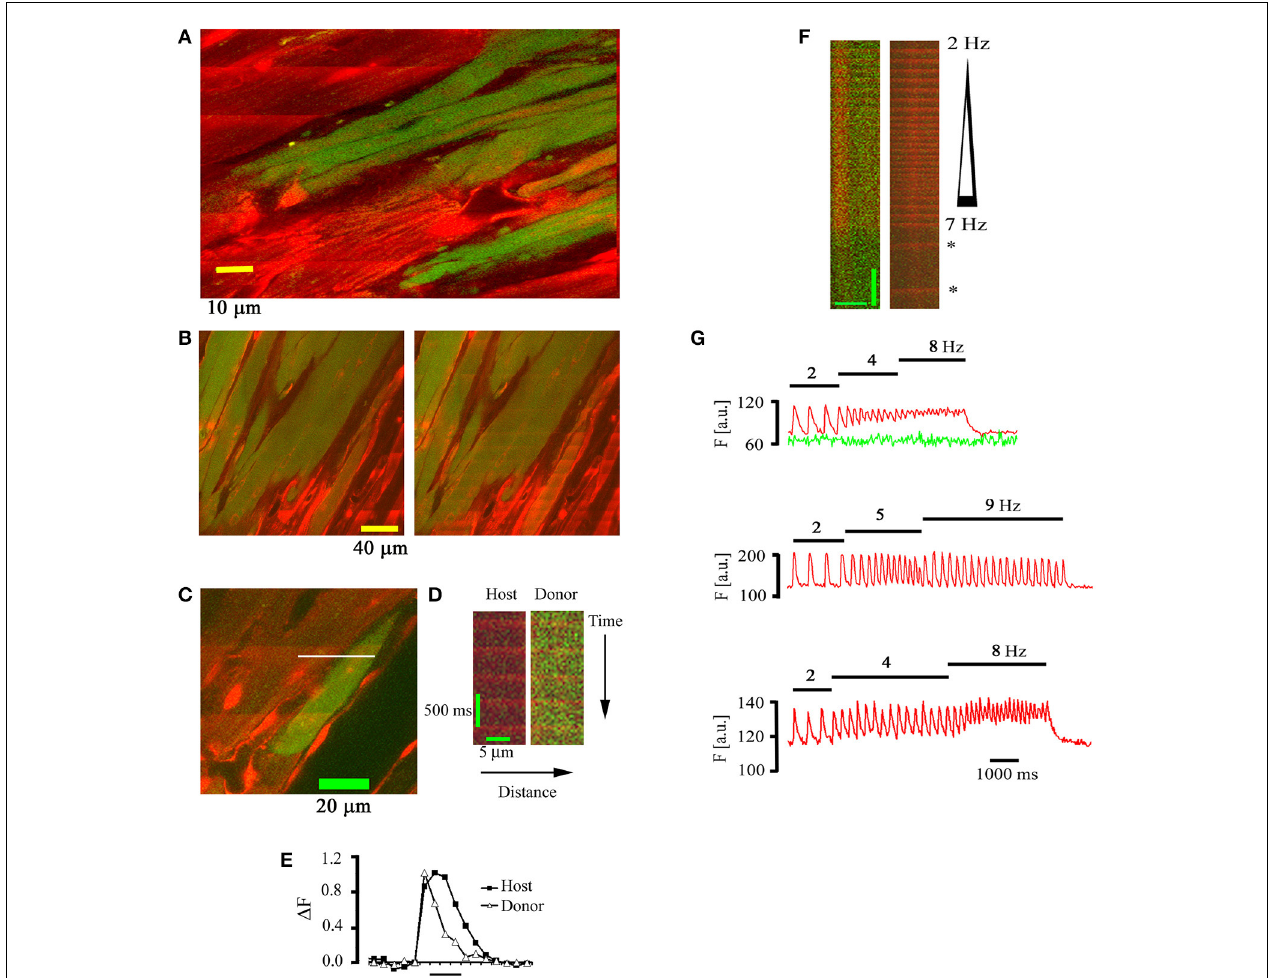
FIGURE 5 | Electrically evoked [Ca 2 + ] i transients in skeletal muscle grafts. (A) Frame-mode image obtained at the graft-host border 18 days following intracardiac transplantation of EGFP-expressing skeletal myoblasts into a non-expressing mouse heart. The heart was continuously paced at a rate of 3Hz at a remote point. Note the absence of electrically evoked rhod-2 transients in the skeletal muscle graft. (B) Frame-mode images obtained at the cardiac-skeletal muscle border obtained during spontaneous sinus rhythm (left panel) and electrical field stimulation (75V, 1ms, 4Hz). (C) Frame mode image obtained from the skeletal-cardiac muscle junction in a rhod-2 loaded mouse heart 22 days following the transplantation of EGFP-expressing skeletal myoblasts. (D) Line-scan image obtained by repeatedly scanning along the